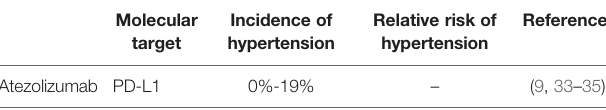
TABLE 2 | Hypertension risk with programmed death ligand 1 (PD-L1) antibodies.